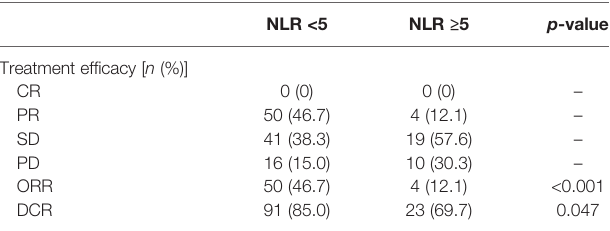
TABLE 2 | Comparing treatment ef fi cacy between two